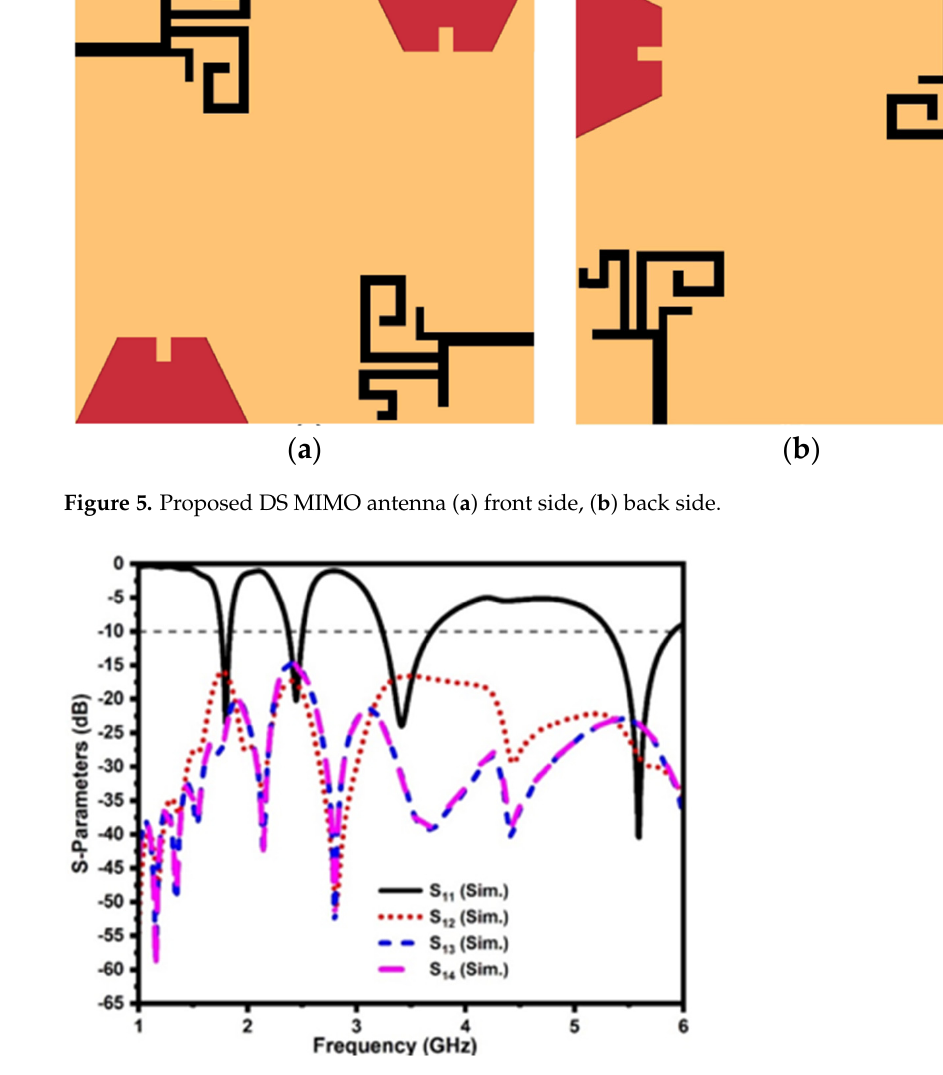
Figure 6. Simulated S − parameters of the proposed DS MIMO antenna.